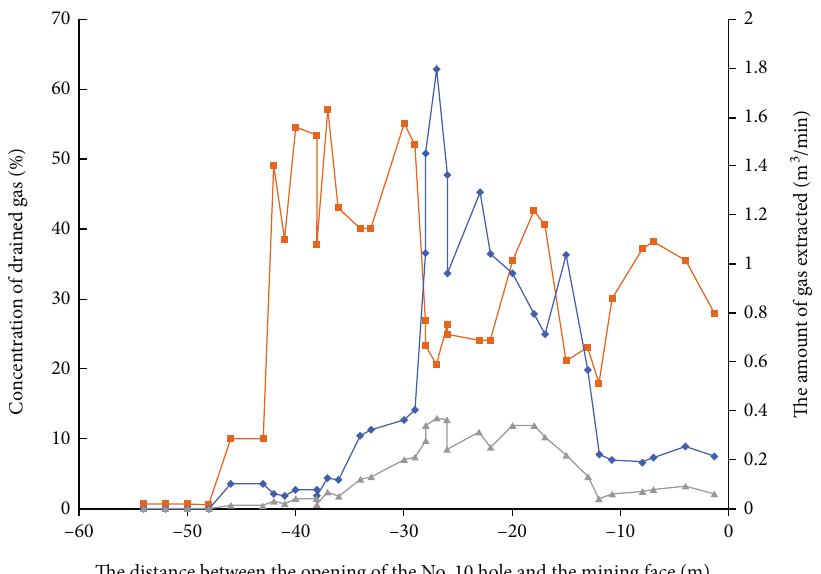
Figure 5: The relationship between the extraction parameters of the No. 5 hole and the advancing step distance.